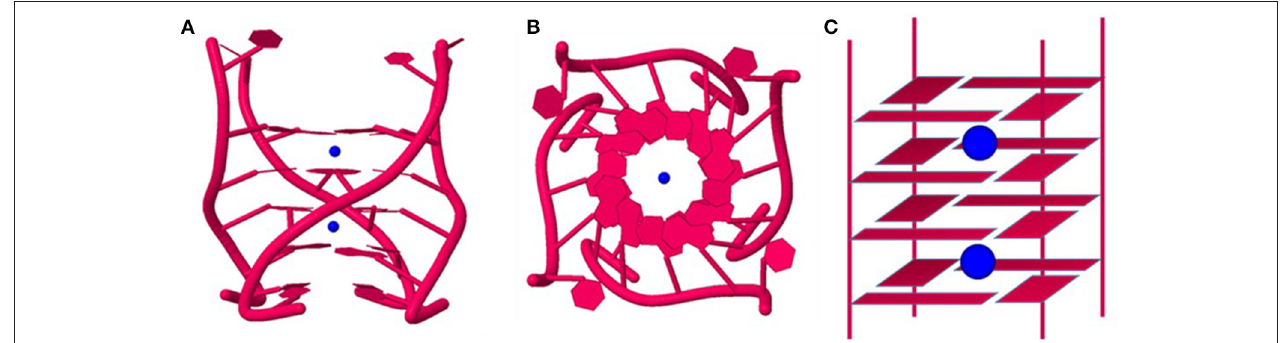
FIGURE 5 | Crystal structure of RNA G-quadruplex formed by the sequence (UGGGGU)4 in the presence of Sr 2 + ions. The side view (A) and the view down the central ion channel (B) of the quadruplex. The schematic representation (C) shows that each Sr 2 + ion is sandwiched by two G-quartets. (PDB entry 1J8G).